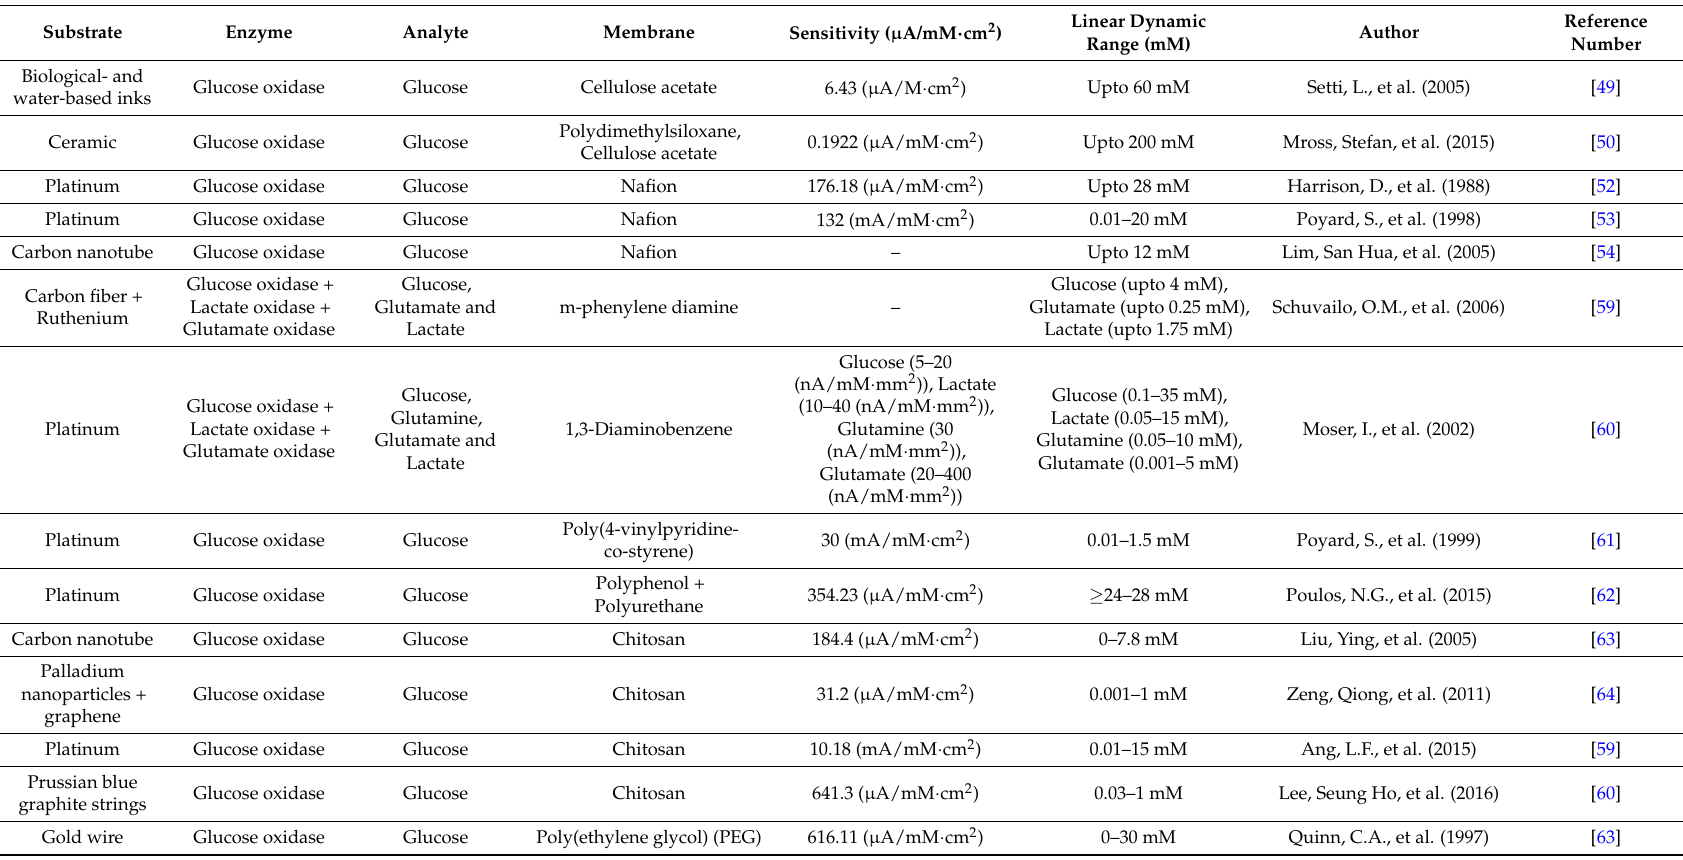
Table 2. Summary of Semipermeable Membrane in Glucose